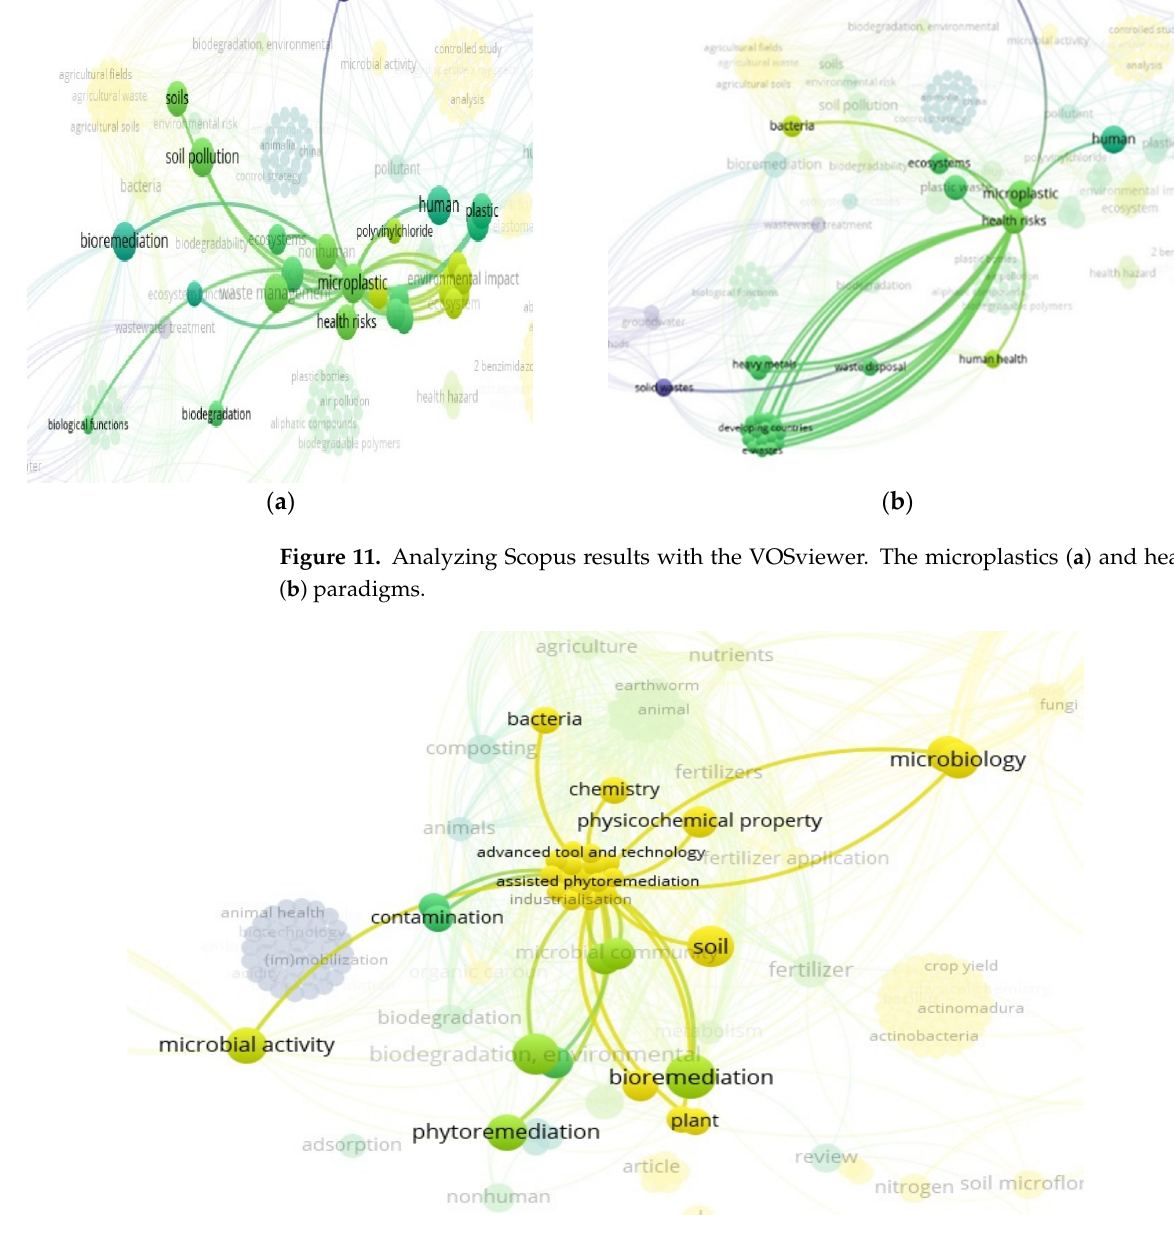
Figure 12. Analyzing Scopus results with the VOSviewer. The assisted phytoremediation paradigm.